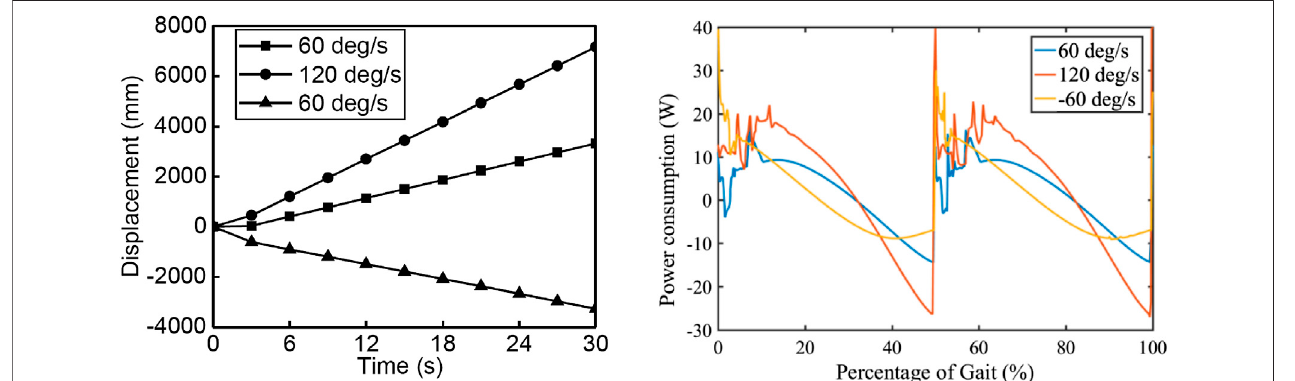
FIGURE 10 | Displacements of the robot with different walking speeds and energy consumption of the robot.